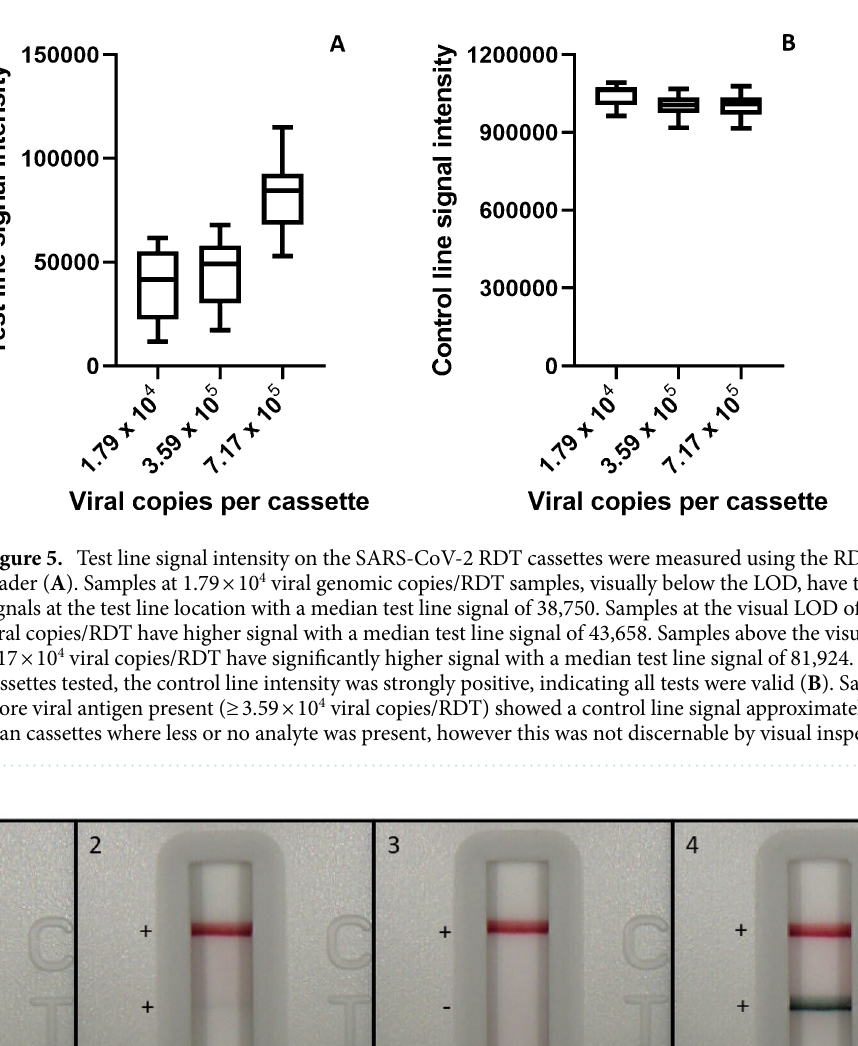
in Fig. 5A). Visual images of representative RDTs are therefore shown in Fig. 6 to highlight the intensity level of the band for each level of inactivated virus-spiked negative nasal swab samples alongside a RT-qPCR posi- tive swab sample. Weak positive blue test lines were visible in the “T” location of cassettes 1 and 2, both at and above 3.59 × 10 4 viral copies/RDT. No test line was visible on cassette 3, below 3.59 × 10 4 viral copies/RDT. For a comparison, the RT-qPCR positive swab sample demonstrates a clearly visible test line on cassette 4. Control lines were visible at location “C” for all cassettes 1–4. Clinical sample performance testing. Clinical sample performance testing as outlined by the FDA EUA recommendation is a minimum of 30 positive specimens and 30 negative specimens collected either retrospec- tively or prospectively. Tests should demonstrate a minimum sensitivity of ≥ 80% for sample types tested 14 . Ret- rospective nasal samples collected into saline were mixed with 10X extraction buffer to mimic our intended sample-extraction buffer concentration and run on RDT cassettes; all samples were tested for SARS-CoV-2 by RT-qPCR using the ExoDx COVID-19 RT-qPCR Test (a CLIA-validated FDA EUA-authorized CDC protocol; this assay has an LOD of ≤ 0.85 copies/µL). Samples are considered positive by RT-qPCR if both the N1 and N2